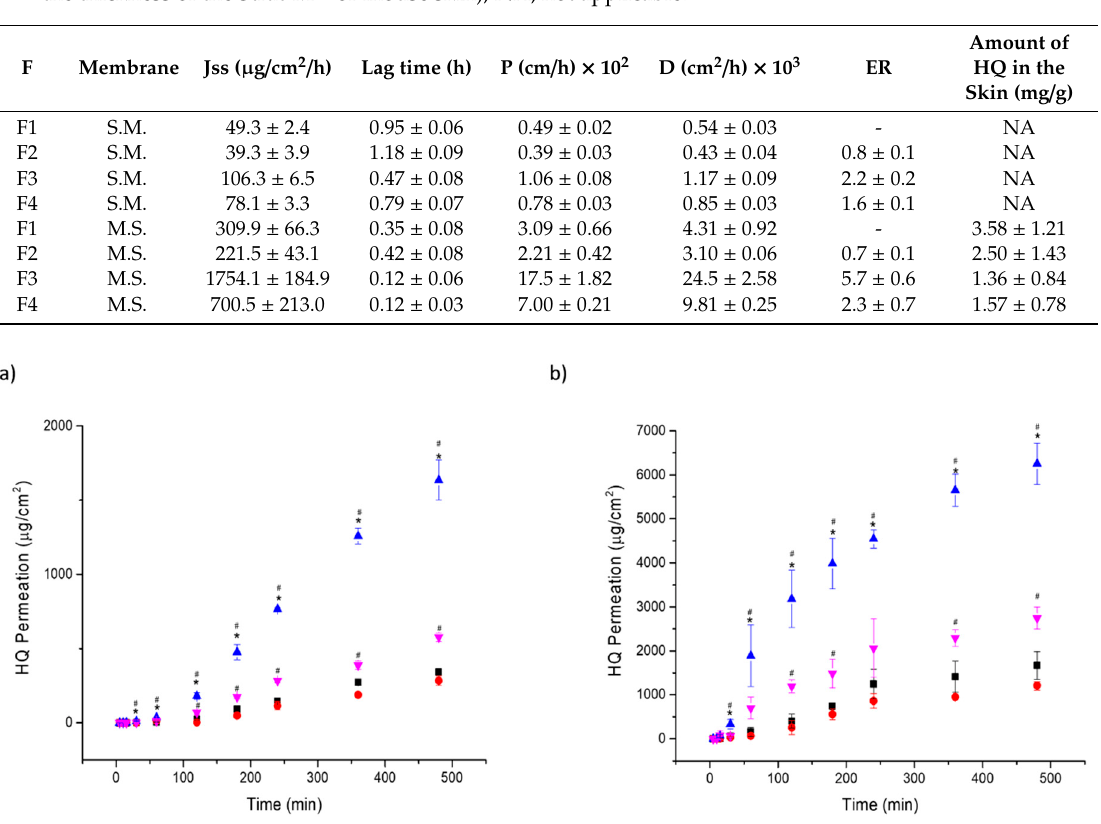
Figure 5. In vitro permeability of HQ formulations across different membranes. a) Strat-M® membrane; b) Mouse skin. Key: - ■ - Formulation 1; - ● - Formulation 2, - ▲ - Formulation 3; - ▼ - Formulation 4. # p-value < 0.05 compared to Formulation 1 and * p -value < 0.05 compared to Formulation 4. Another factor that can potentially explain the di ff erences in permeability amongst the four formulations is the drug release kinetic (Table 5). The release profiles can be best explained by the Higuchi and Korsmeyer–Peppas models, as the plots show high linearity ( R 2 > 0.99). The permeation ® of the four formulations across Strat-M followed a Korsmeyer–Peppas release with n values ~